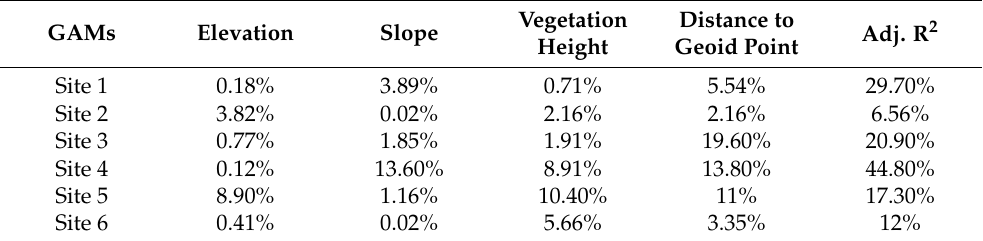
Table 8. Univariate generalized additive models (GAMs) of each site-specific factor to estimate their relative importance in explaining the vertical errors of DEMs derived from low-density LiDAR. The response variable is the vertical error of each site. All classification filters are included maintaining the interpolation method (TIN) and the spatial resolution (5